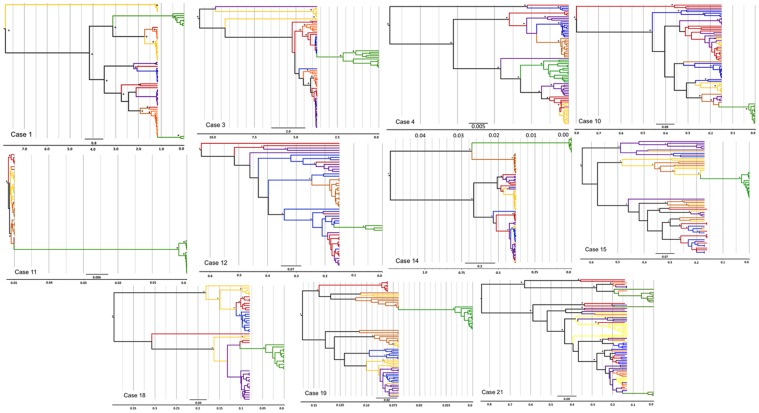
Phylogenetic reconstruction of the most recent common ancestor (TMRCA).This image illustrates the Bayesian maximum clade credibility (mcc) trees inferred in BEAST. Terminal branch colors represent sequences derived from the infant DBS DNA (green), maternal plasma (red), left breast milk DNA (purple), left breast milk RNA (orange), right breast milk DNA (blue) and right breast milk RNA (yellow). Unambiguous internal branches are shaded according to the compartment of origin or shaded black if the origin was ambiguous. Timelines indicate the number of years in the past from the date of sample collection of the infant DBS, indicated as Time 0.